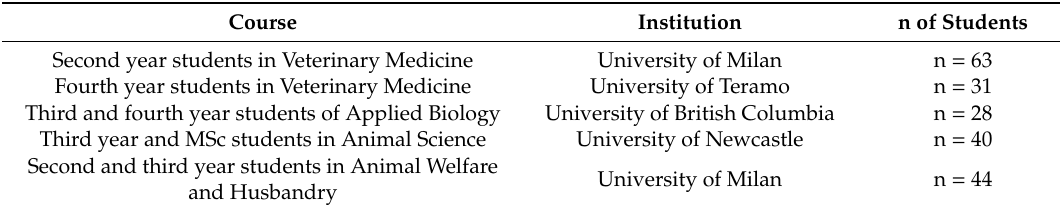
Table 1. Number of recruited students from each institution.